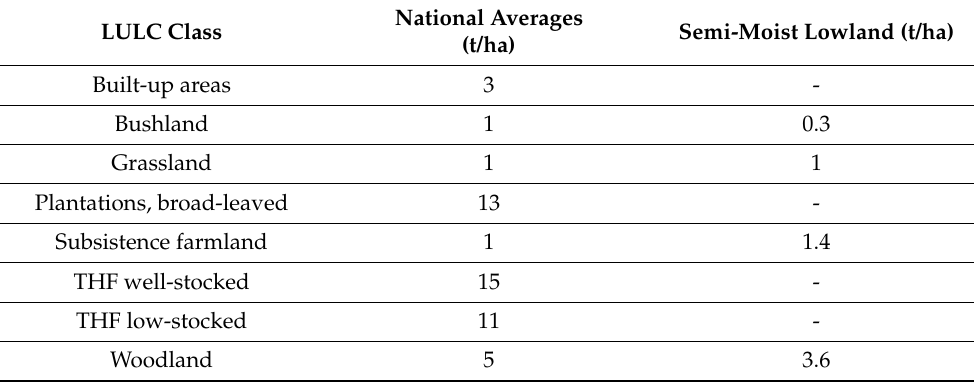
Table 4. Biomass growth annual increment (air-dry matter) for selected LULC classes, as national averages and for semi-moist lowlands. National Averages Semi-Moist Lowland (t/ha) LULC Class (t/ha) Built-up areas 3 - Bushland 1 0.3 Grassland 1 1 Plantations, broad-leaved 13 - Subsistence farmland 1 1.4 THF well-stocked 15 - THF low-stocked 11 - Woodland 5